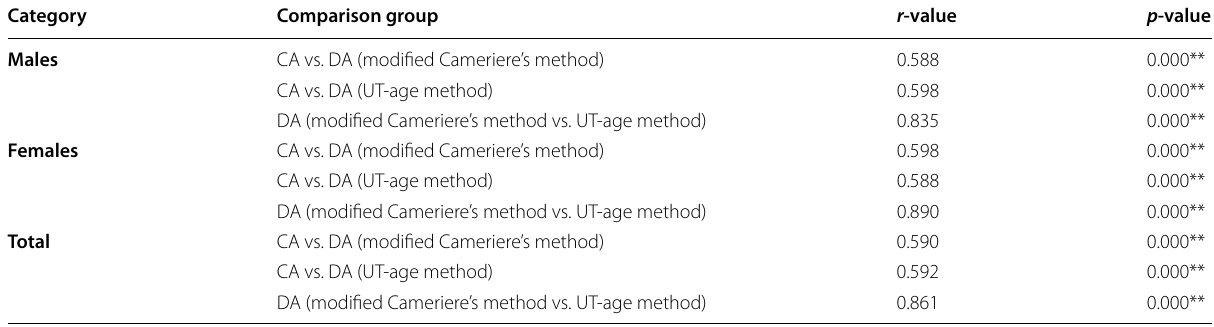
Table 4 Pearson’s correlation coefficient test between chronological age and estimated dental age using two methods (males, female, and total)